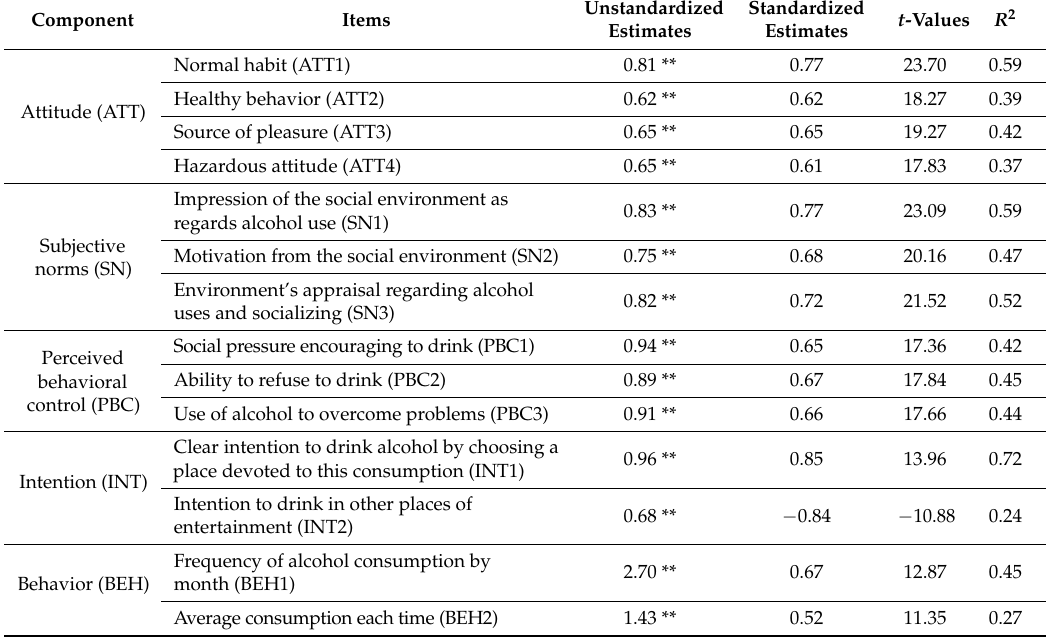
Table 5. Measurement